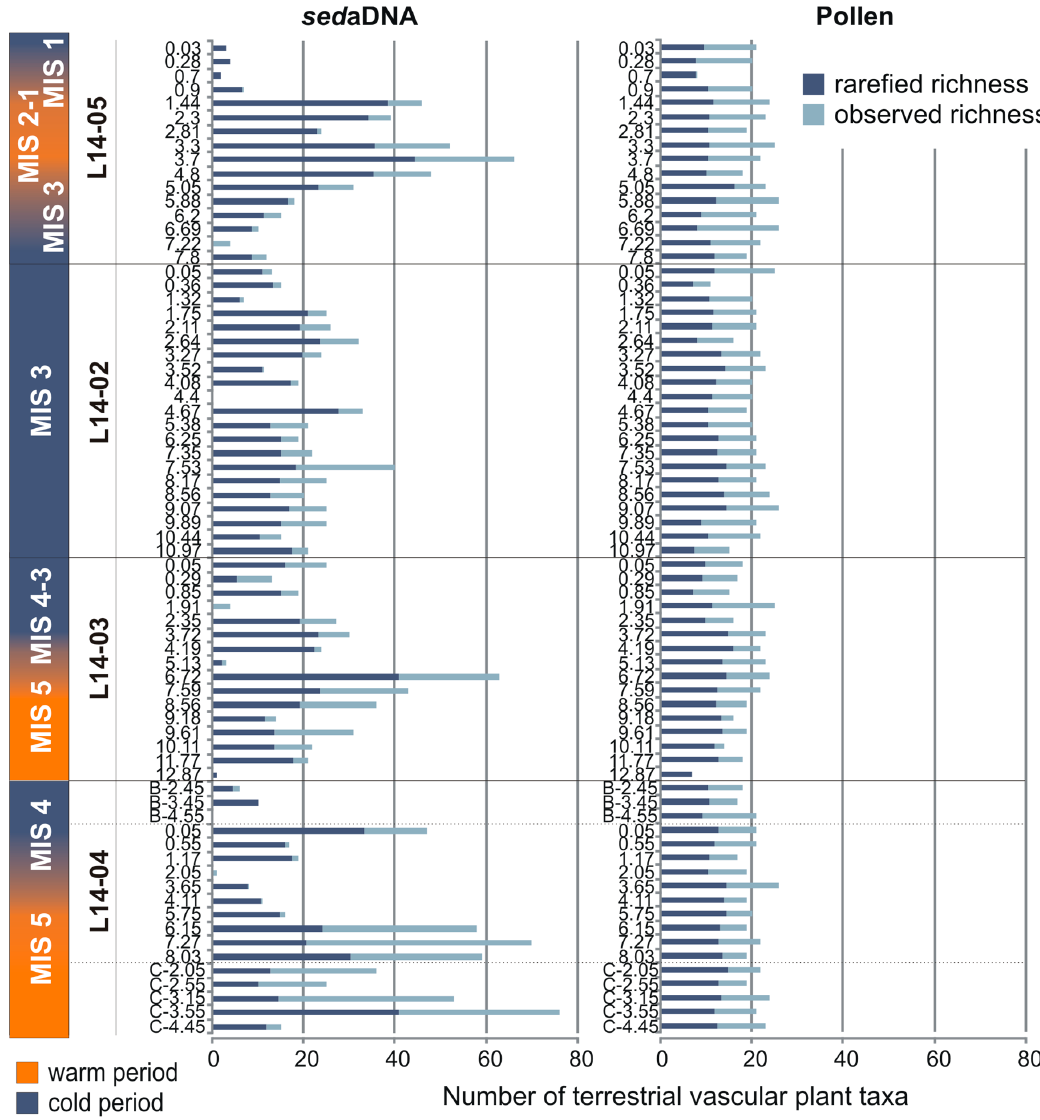
Figure 4. Richness of observed (light blue) and rarefied (dark blue) terrestrial vascular plant taxa for the sedaDNA and pollen datasets. The corresponding MIS are displayed on the left side, with warmer periods in orange and colder periods in blue.